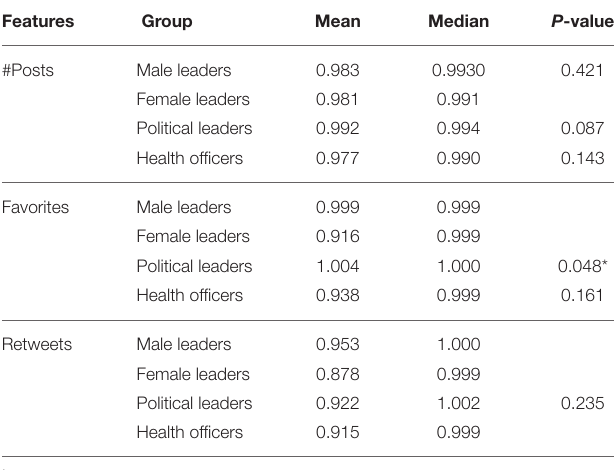
TABLE 2 | Distrust in replies of posts authored by health leaders.